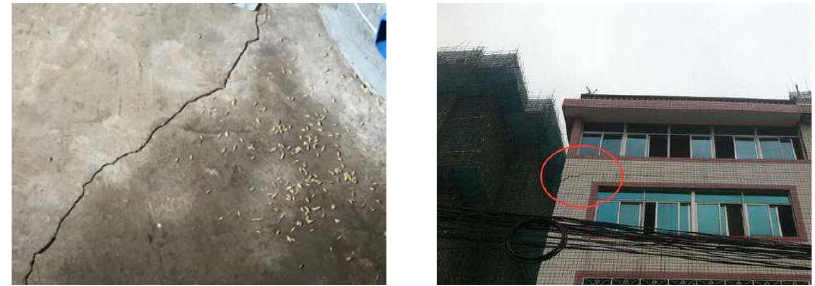
Figure 1. Building crack cases.